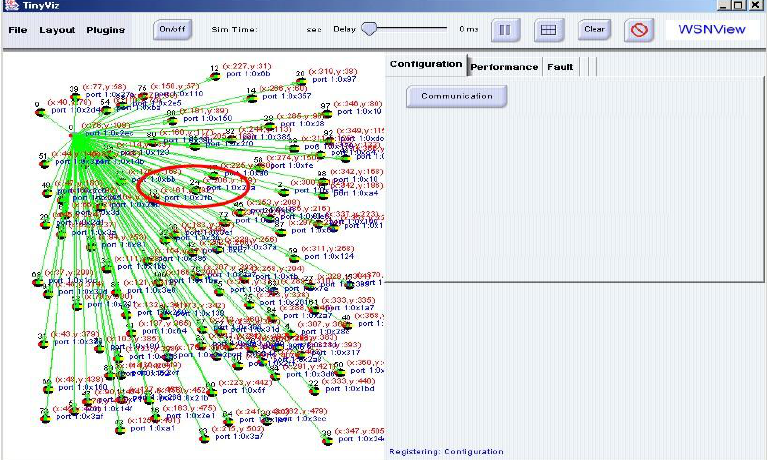
Figure 6. Configuration after Adjusting the Sensor